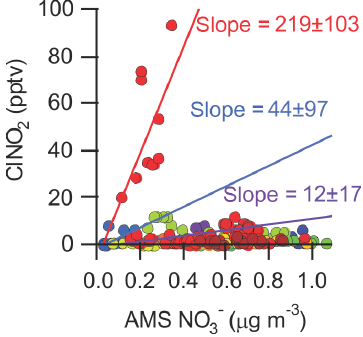
Figure 9. Scatter plot of ClNO 2 mixing ratios with submicron (PM 1 ) ACSM NO − data. The slopes were calculated for three pe- 3 riods: 2 August, 01:25–04:55 (red dots; slope = 219 ± 103; ϕ = 0 . 72), 23 July, 03:00–04:25 (blue dots slope = 44 ± 97; ϕ = 0 . 21), and 21 July, 02:25–05:20 (purple dots slope = 12 ± 17; ϕ = 0 .